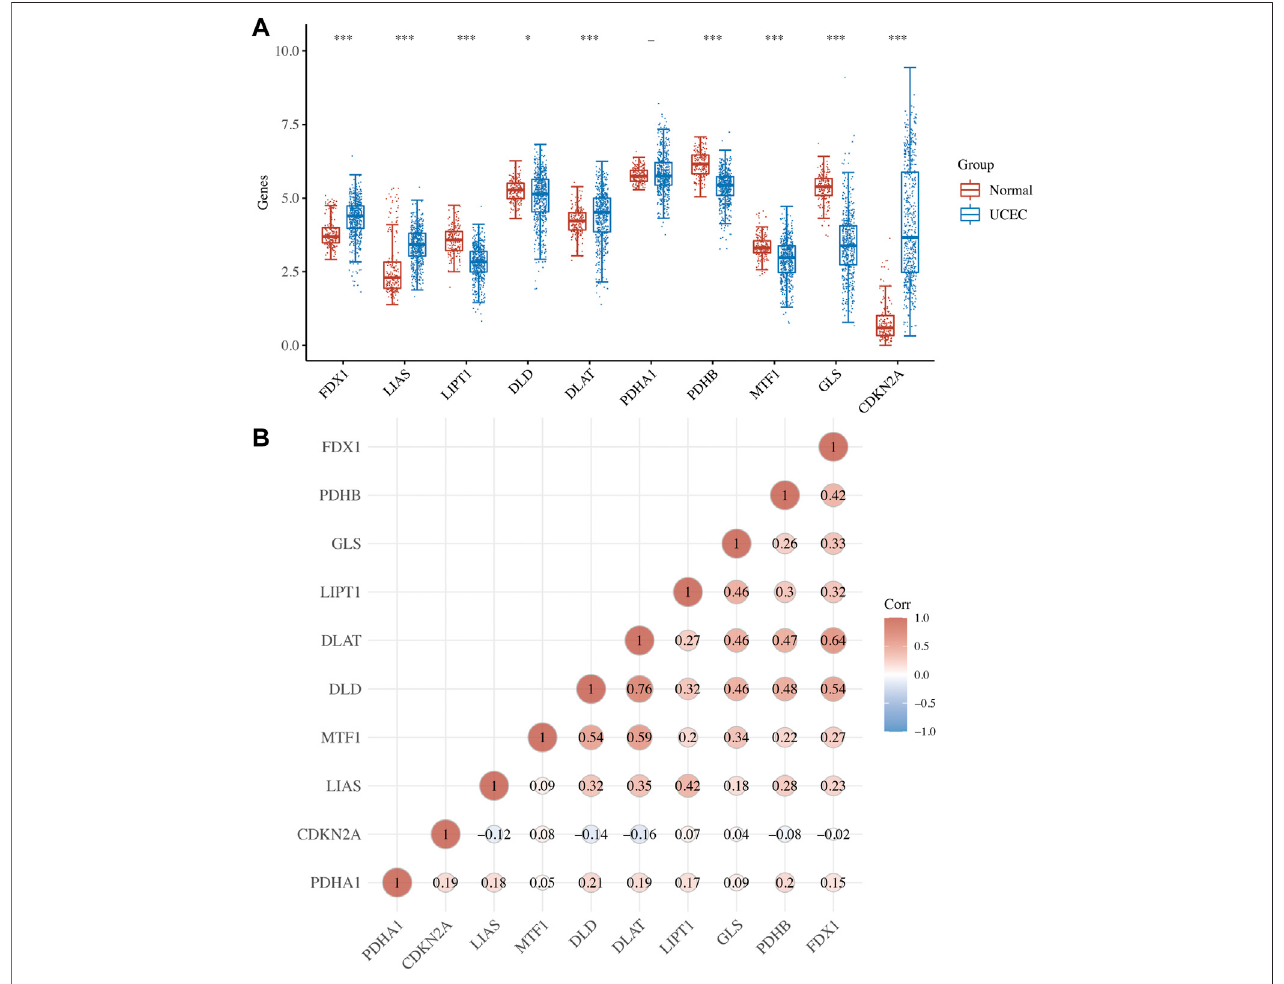
FIGURE1| Expressionofcuproptosis-relatedgenes(CRGs) inuterinecorpusendometrialcarcinoma(UCEC). (A) ThemRNAlevelofCRGinUCECversusnormal tissues. (B) The correlation between each member of CRG in UCEC. * p < 0.05; ** p < 0.01; and *** p < 0.001; — p > 0.05.